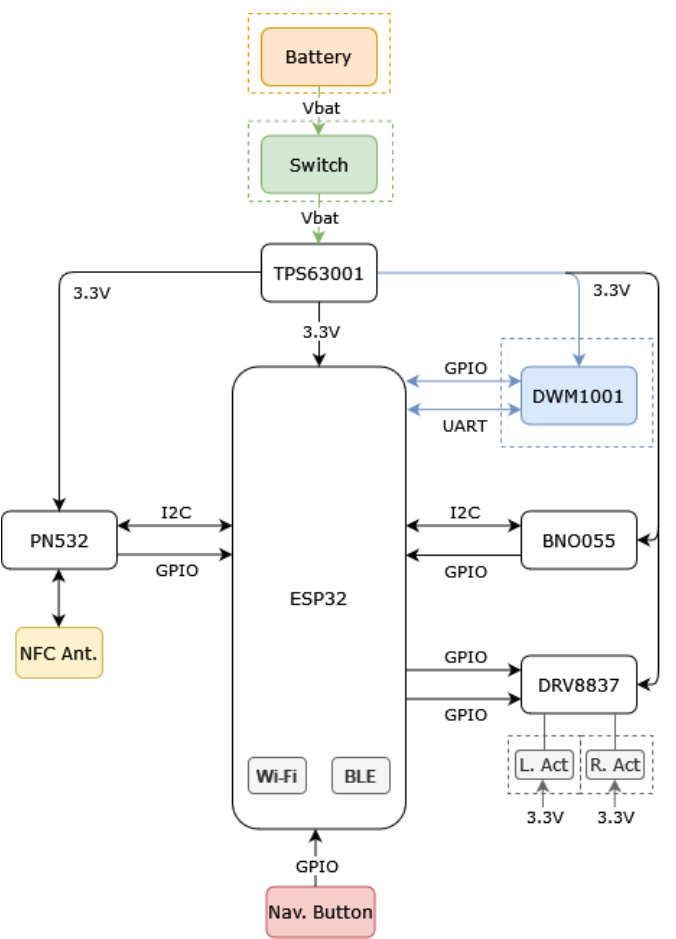
Figure 1. Architecture of the smart lifejacket.